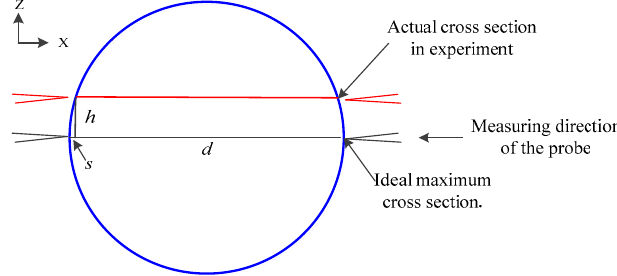
Figure 9. Principle of the visual alignment error.